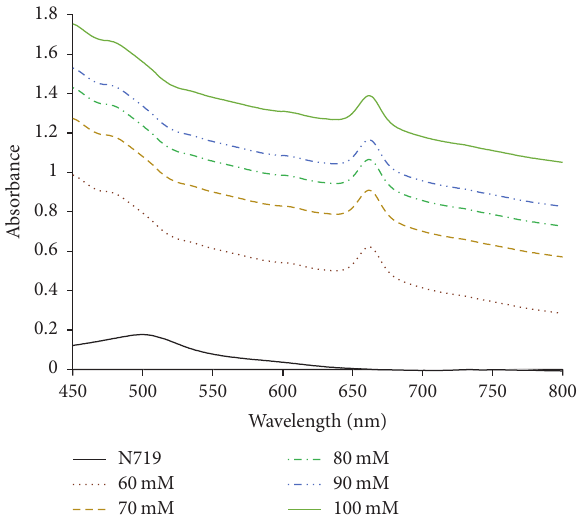
Figure 5: UV-Vis absorption spectra of the solutions containing dyes detached from TiO 2